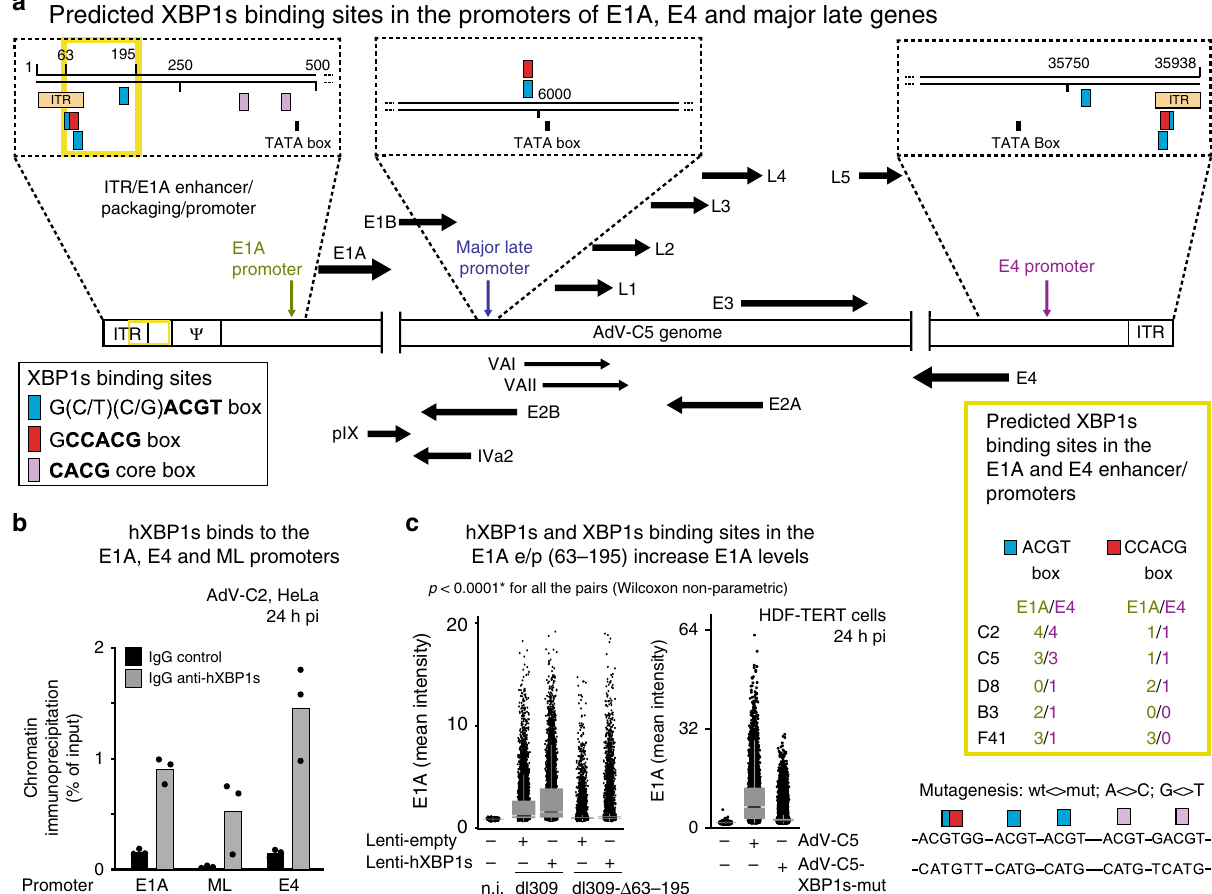
Fig. 6 XBP1s binds to predicted sites on the AdV E1A and E4-e/p. a Schematics depicting the XBP1-binding sites (blue and red boxes) and consensus- binding sequences on the E1A, E4, and major late (ML) promoters in AdV-C5 genome. The letter psi denotes the packaging sequence near the inverted terminal repeat (ITR). The yellow box on the right shows the conservation of predicted XBP1s-binding sites in the E1A and E4 promoters in different human AdV types. b Chromatin immunoprecipitations from AdV-C2-infected cells using anti-XBP1s and control IgG antibodies. The data show the fold enrichment of XBP1s on the AdV-C2 promoters (in particular the E1A and the E4 promoters) with anti-XBP1s versus control antibodies, as calculated using